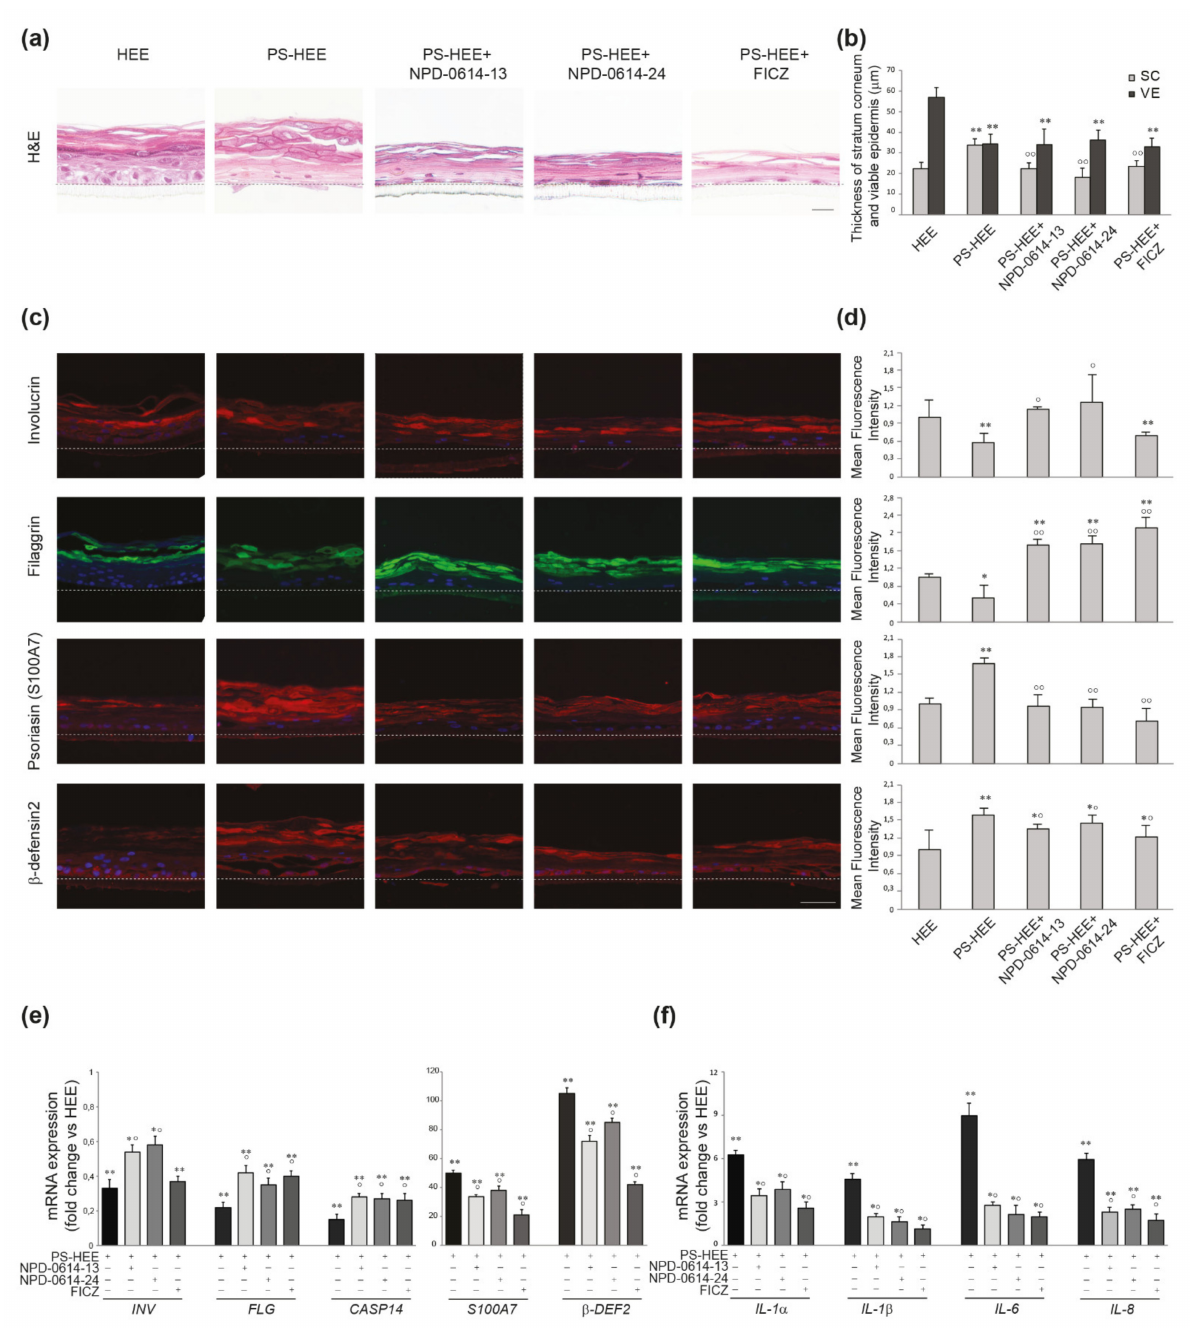
Figure 7. Effects of NPD-0614-13 and NPD-0614-24 on psoriasis-like human epidermal equivalents (PS-HEEs). ( a ) Hematoxilin–eosin staining of HEEs and PS-HEEs cultured in the presence or absence of NPD-0614-13, NPD-0614-24 (25 µ M) and FICZ (100 nM) for 72 h. Bar: 50 µ m. ( b ) Morphometric analysis of stratum corneum (SC) and viable epidermal layers (VE). The thickness of SC and VE was expressed as mean value ± SD (significance vs. untreated HEEs or vs. PS-HEEs are marked with * and ◦ , respectively; ** p < 0.01 vs. untreated HEEs; p < 0.01 vs. PS-HEEs). ( c ) Representative immunofluorescence images after using antibodies against involucrin, filaggrin, S100A7, and beta-defensin-2. Nuclei were counterstained with DAPI. Bar: 20 µ m. ( d ) Quantitative analysis of fluorescence intensity was expressed as mean value ± SD (* p < 0.05, ** p < 0.01 vs. untreated HEEs; ◦ p < 0.05, ◦◦ p < 0.01 vs. PS-HEEs). Dashed black/white lines represent the junction between the basal layer and the membrane of the insert. Quantitative real time PCR analysis of the expression of ( e ) involucrin, filaggrin, caspase-14, S100A7, beta-defensin 2, and ( f ) IL-1 α , IL-1 β , IL-6, and IL-8 in PS-HEEs in the presence of absence of NPD-0614-13, NPD-0614-24 (25 µ M), or FICZ (100 nM) for 72 h. All mRNA values were normalized against the expression of GAPDH and were expressed relative to untreated HEEs (* p < 0.05, ** p < 0.01 vs. HEEs; p < 0.05 vs.